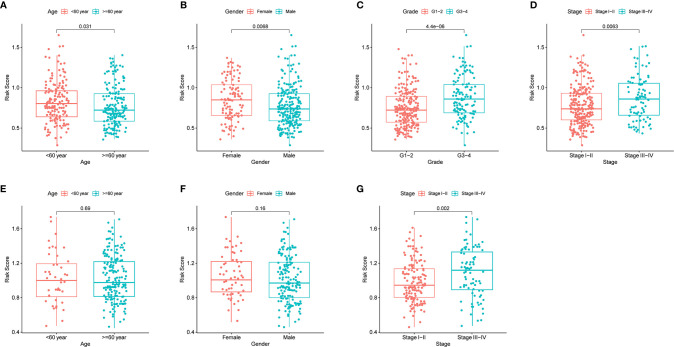
The risk score in different groups divided by clinical characteristics. TCGA cohort (A–D), ICGC cohort (E–F). (A, E) Age. (B, F) Gender. (C) Tumor grade. (D, G) Tumor stage.